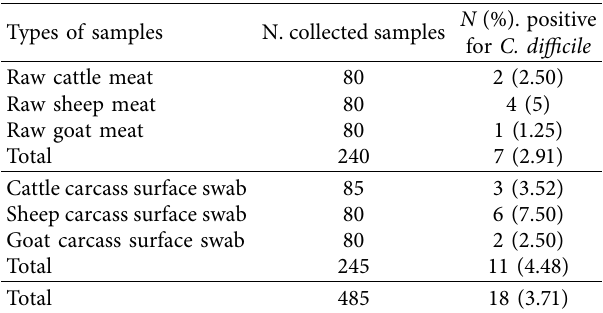
Table 2: C. difcile prevalence amongst the examined raw meat and surface carcass swab